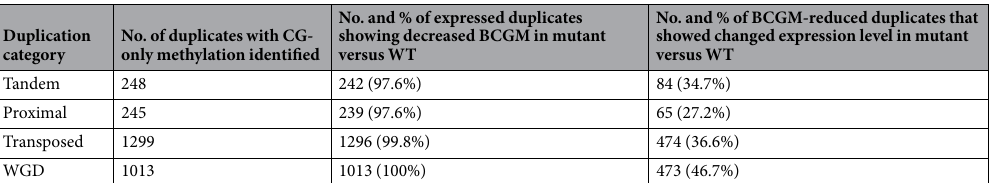
Table 2. Statistics of duplicates with CG-only methylation that showed loss of BCGM (body CG methylation) in the OsMet1-2 mutant, and the proportion that showed changed expression levels in the